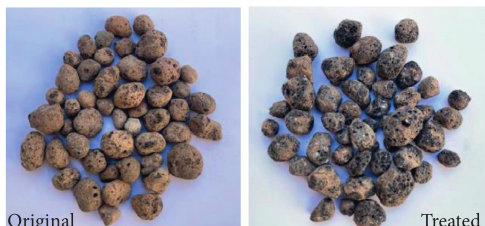
Figure 1: Original (smooth surface) and treated (rough surface) lightweight aggregate used.